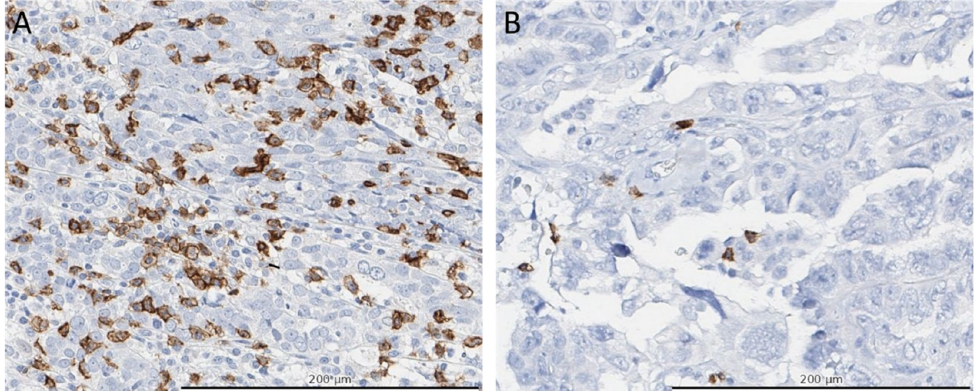
Figure 1. Immunohistochemical (IHC) staining of CD8+ cells. Panels ( A , B ) depict representative areas of the IHC stained TMA’s for CD8+ cells (brown colored cells) of two separate patients. Panel ( A ) shows a high CD8+ density (>100 cells in the entire TMA) and panel ( B ) a low density (<20 cells in the entire TMA). Total numbers of CD8+ cells were manually counted per core and scored as 0, 1–5, 6–19, 20–49, 50–100, or >100 positive cells and categorized in low, medium, and high densities based on the 25th and 75th percentiles and the median of all patients.